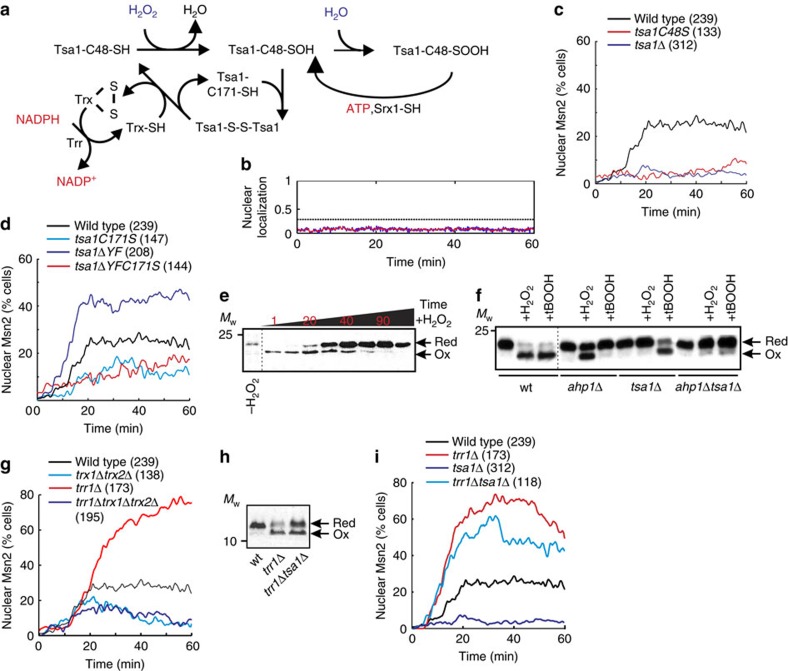
The light-induced H2O2 signal is transduced by the peroxiredoxin Tsa1 which instantly relays the signal to the cytosolic thioredoxins.(a) Overview of catalysis in Tsa1, a typical two-cysteine peroxiredoxin. H2O2 is reduced by Tsa1-C48-SH, which is oxidized to a sulfenic acid intermediate (Tsa1-C48-SOH), which subsequently condenses with the resolving cysteine (C171-SH) of another Tsa1 molecule, producing a disulfide-bonded Tsa1 dimer. This disulfide bond is subsequently reduced by thioredoxin (Trx), completing the catalytic cycle. A proportion of C48-SOH becomes hyperoxidized to the sulfinic acid form (C48-SOOH) in each catalytic cycle, inactivating peroxidase activity. Sulfiredoxin (Srx1) reduces C48-SOOH, allowing Tsa1 to re-enter the catalytic cycle. (b) Single-cell trace of Msn2 nuclear localization in a typical tsa1Δ cell following illumination at 115 μW. (c,d,g,i) Fraction of cells of the indicated strains displaying nuclear localization following illumination at 115 μW. The number of cells assayed in each analysis are indicated in brackets. (e) Trx2 oxidation assayed by redox immunoblot analysis of a strain expressing ProteinA-tagged Trx2. Samples for redox immunoblot analysis were withdrawn before and 1, 10, 20, 30, 40, 60, 90 and 120 min following H2O2 addition (0.3 mM). Red, reduced form; Ox, oxidized form. See also Supplementary Fig. 2l. (f) Trx2 oxidation in Tsa1- and Ahp1-deficient cells upon H2O2 addition (0.3 mM for 1 min) or the addition of t-butylhydroperoxide (tBOOH, 0.3 mM for 1 min). (h) Thioredoxin oxidation in cells lacking Trr1 or both Trr1 and Tsa1. See also Supplementary Fig. 2o.